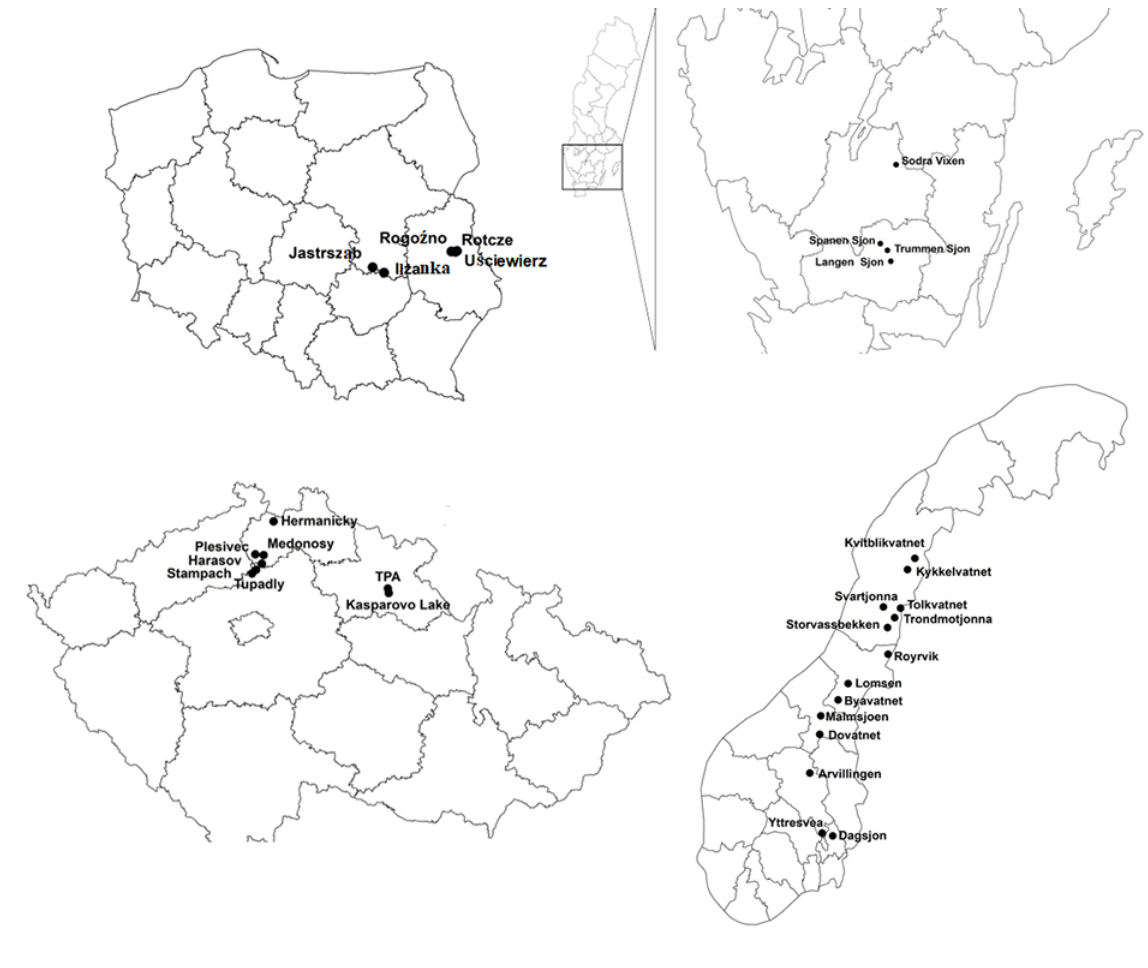
Figure 1 Location of the studied localities: Poland (1), Sweden (2), Czech Republic (3), and Norway